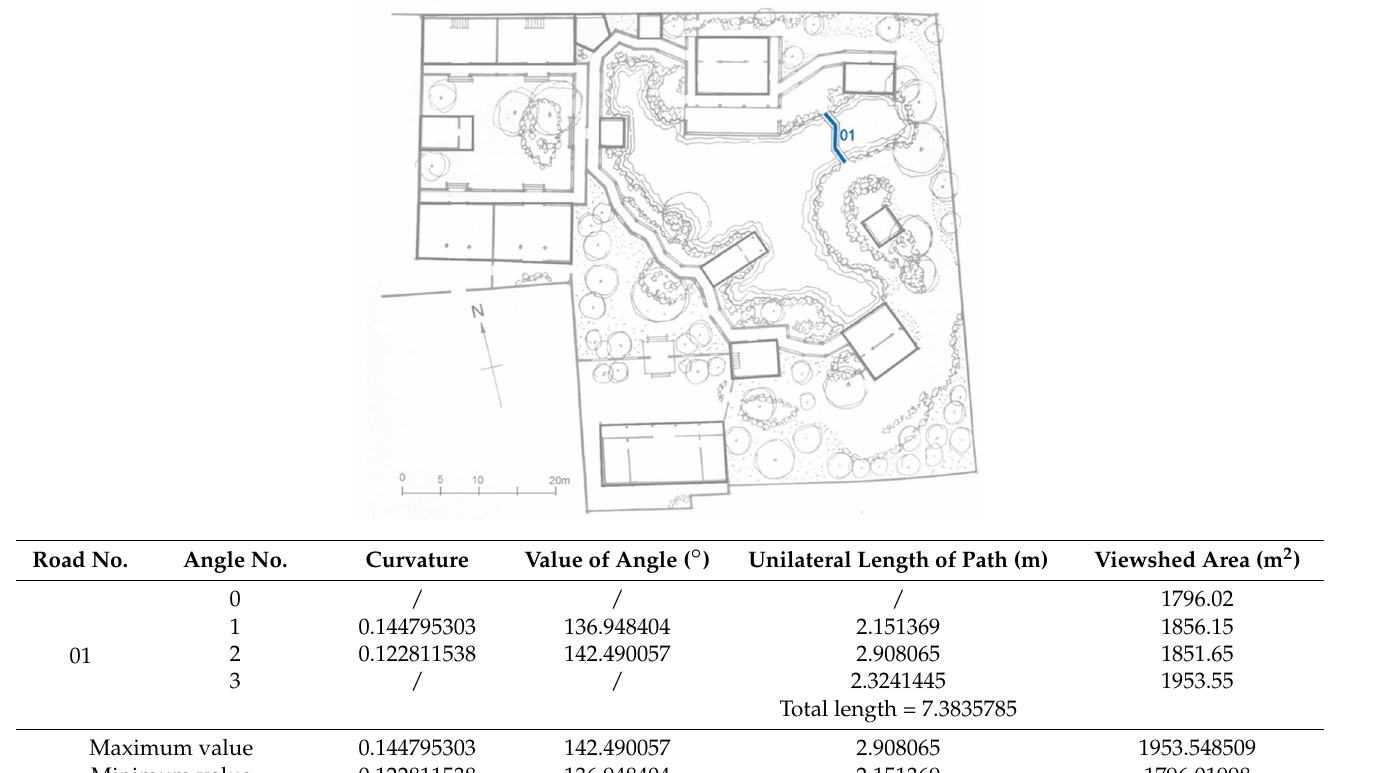
Table A26. Retreat and Reflection Garden, bridge.